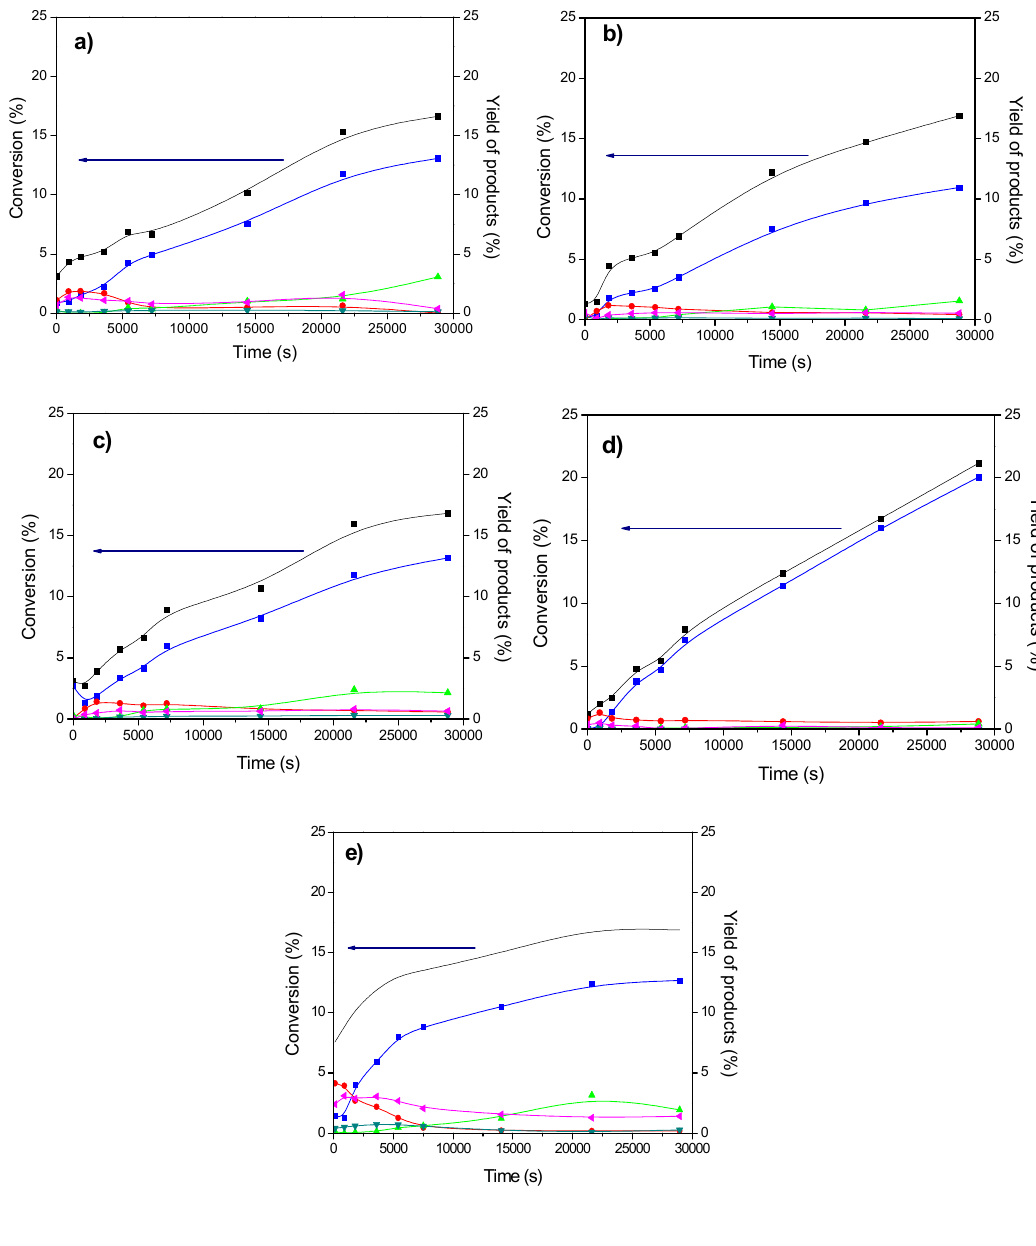
Figure 6. Variation of the transformation of glycerol and the yield of products with time for ( a ) Cu / CGran, ( b ) Cu / CGran(450), ( c ) Cu / CGran(600), ( d ) Cu / CGran(750), ( e ) Cu / CGran(1000) catalysts.